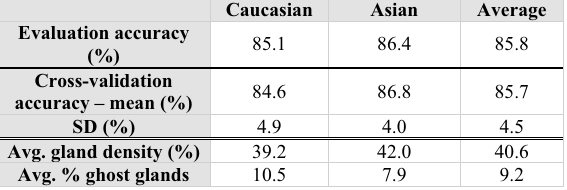
Table 5. Ethnicity prediction results. The model predicts the subject ethnicity with an average accuracy of 86%, and the two most important morphological features are gland density and percentage of ghost glands. First 4 rows: classification accuracy for subject ethnicity prediction of the demographic feature prediction model. The second row reports accuracies on the evaluation set and the last two rows report means and standard deviations of accuracies on the five-fold cross-validation set. Last two rows: average values for the top 2 most highly weighted (largest model coefficients) morphological features stratified on ethnic group.